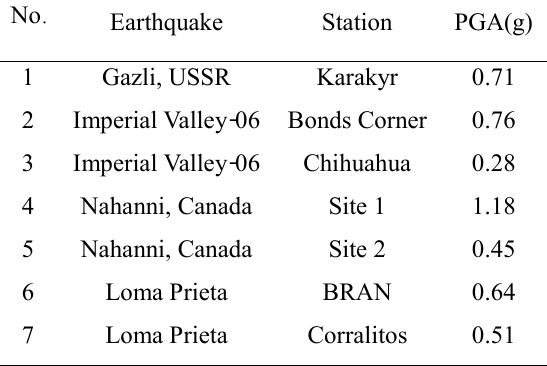
Near-Field Earthquakes Applied to the